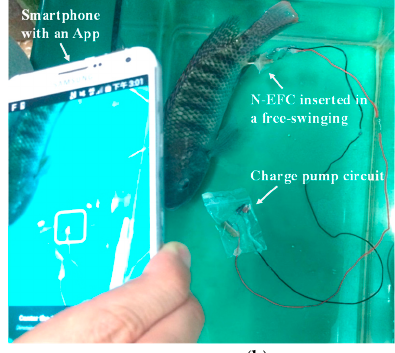
Figure 1. ( a ) Schematic and ( b ) photograph of the self-powered glucose biosensor (SPGB) used to monitor the physiological status of a free-swimming fish in a tank (Tilapia) in real time using a smartphone. The SPGB consisted of a needle-type enzymatic biofuel cell (N-EFC), which was operated underwater and connected with a charge pump IC and an LED as the indicator. The N-EFC was inserted into a living fish (Tilapia) around the caudal area to access biofuels along with a gas- diffusion biocathode sealed in an airtight bag. By using a smartphone with an application (App), the glucose concentration can be determined by measuring the LED blinking frequencies of the SPGB.